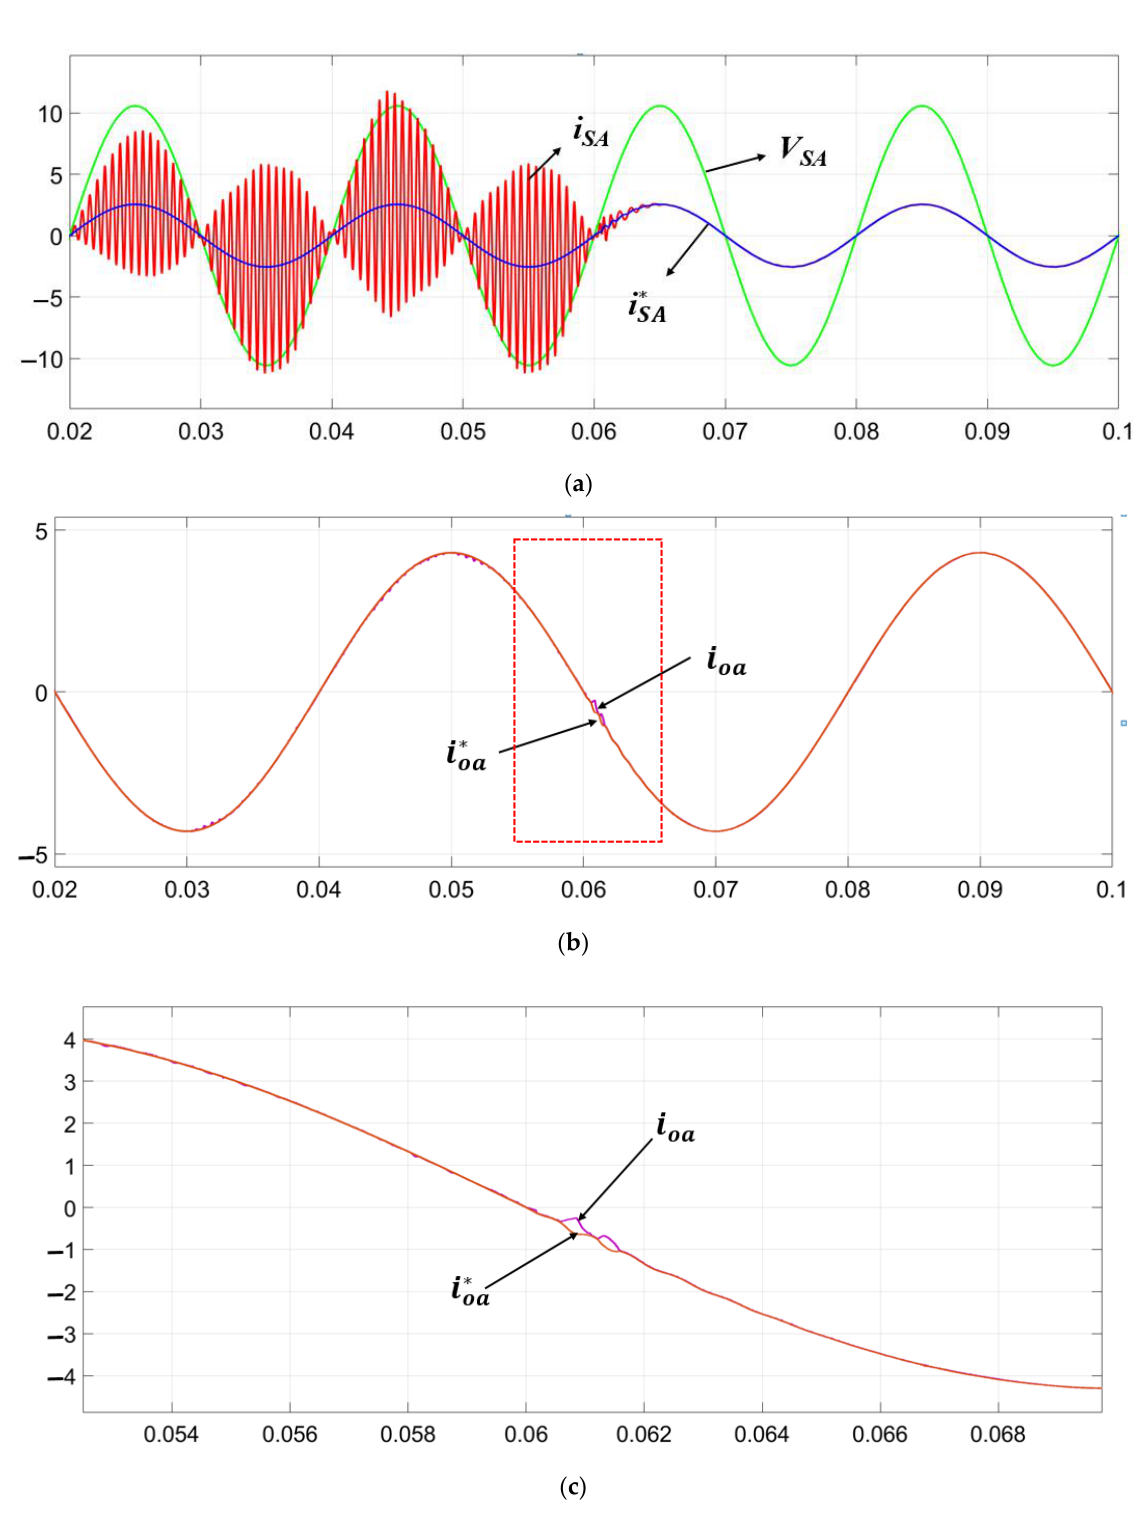
Figure 7. Simulation results of the VMMPC for the TSMC, and output-current frequency reference is set to 50 Hz: The IFRS is added at t = 0.06 s, x-axis unit second: ( a ) source voltage V sA /13 V, source current i sA A and source-current reference